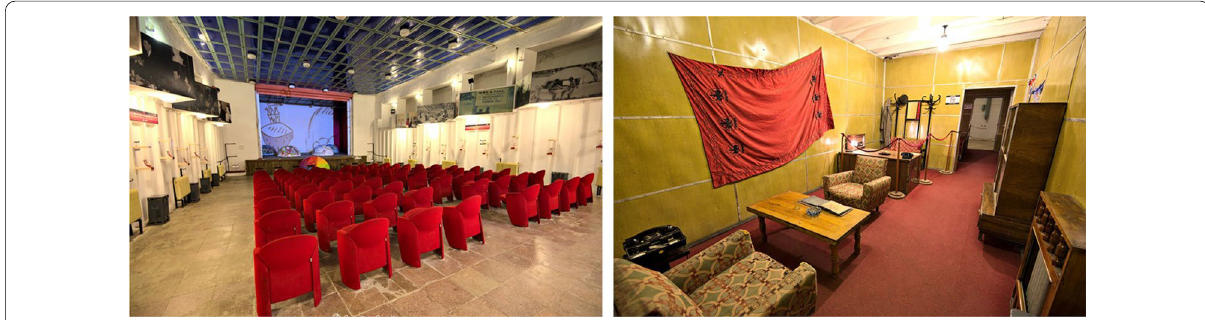
Fig. 7 Photos from the interior of the museum Bunkart 1, curated by Carlo Bollino